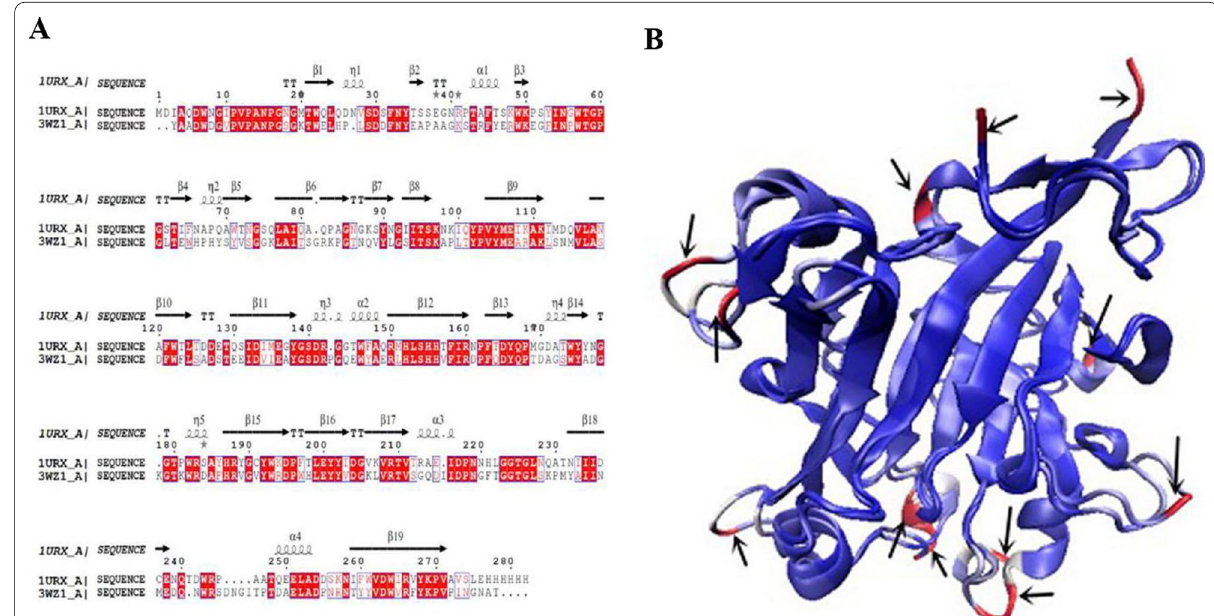
Fig. 1 Sequence alignment ( A ) and structure alignment ( B ) of two β-agarases (1URX and